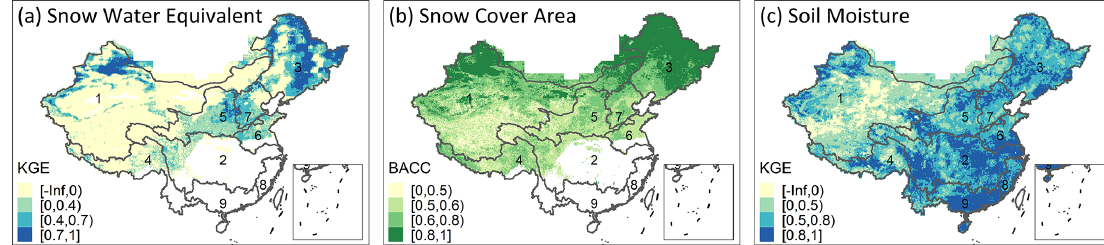
Figure 7. Spatial validation of the reconstructed snow water equivalent (SWE), snow cover area (SCA), and soil moisture (SM). The bench- mark datasets are SD–CN for SWE, MOD10C1/MYD10C1 for SCA, and SMAP-L4 for SM. KGE: Kling–Gupta efficiency, BACC: balanced accuracy. The boundary lines delineate nine major river basins of China: (1) the northwest continental basin, (2) the Yangtze River basin, (3) the Songhua and Liaohe River basins, (4) the southwest basin, (5) the Yellow River basin, (6) the Huaihe River basin, (7) the Haihe River basin, (8) the southeast basin, and (9) the Pearl River